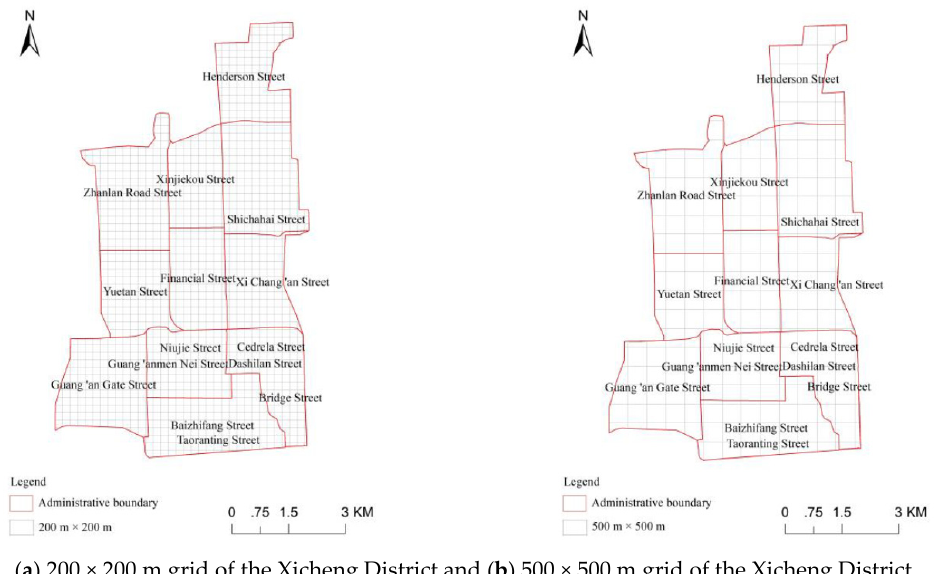
Figure 6. The average density of the POI data and the standard deviation of the average density.